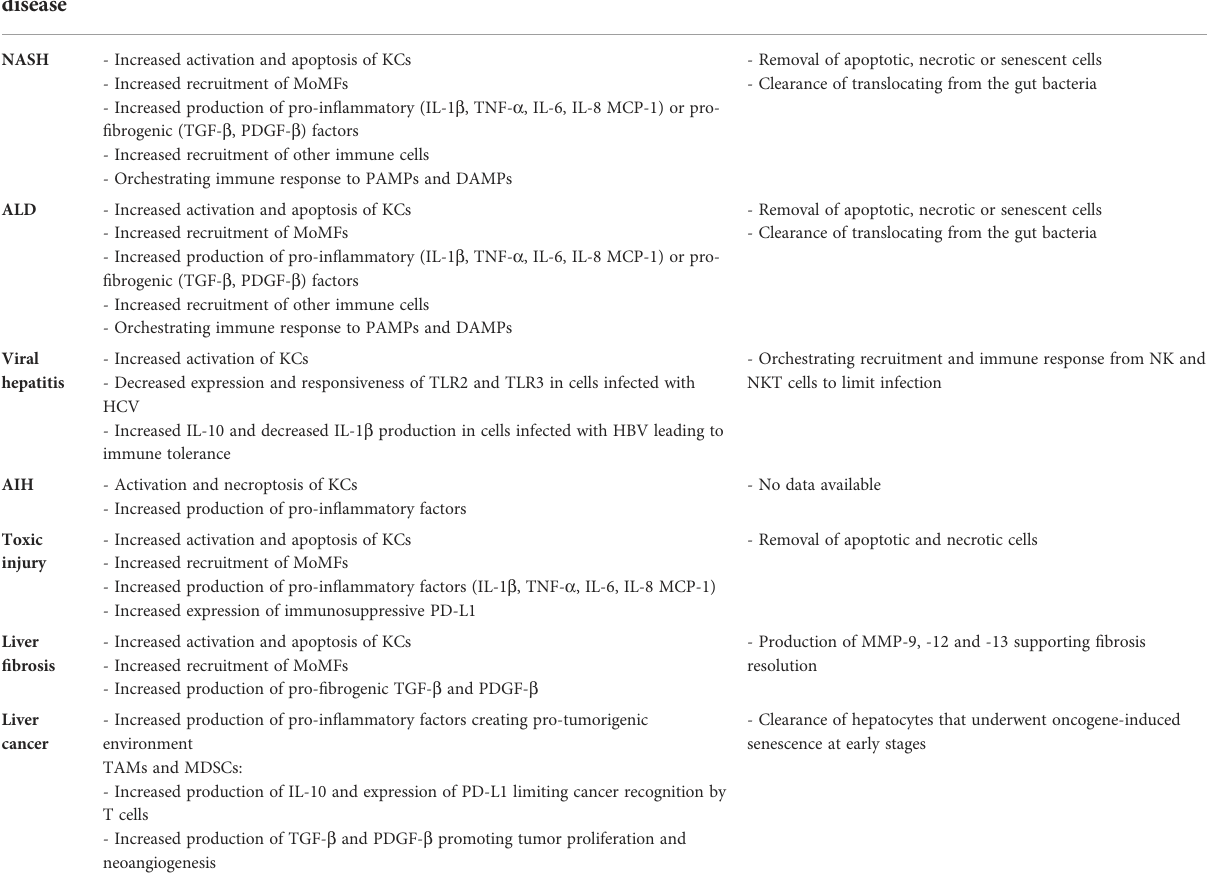
TABLE 4 Effects of disease on tissue-resident macrophages in the